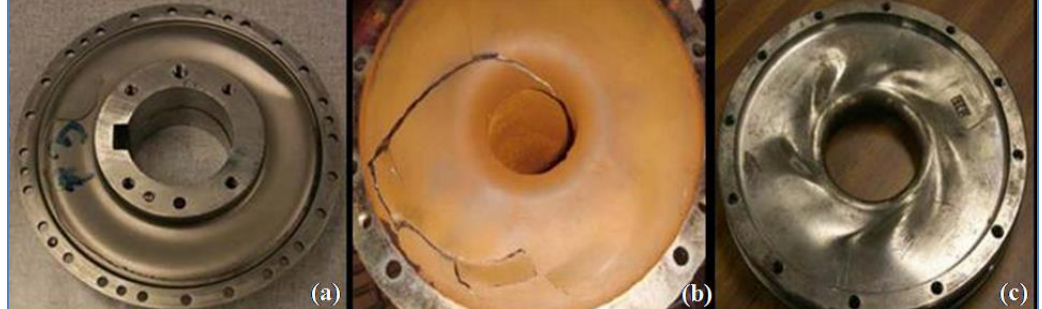
Fig. 3: Various coupling failure types – influence of stress reversal: (a) under excessive angular misalignment and axial displacement, (b) under excessive torsional oscillation, (c) under torque